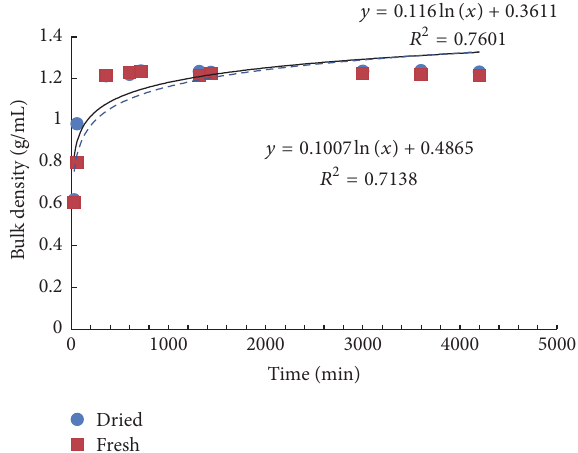
Figure 4: Peleg model kinetic equilibrium extraction of Clinacan- thus nutans fresh and dried leaves ( 𝑛 = 3 ).